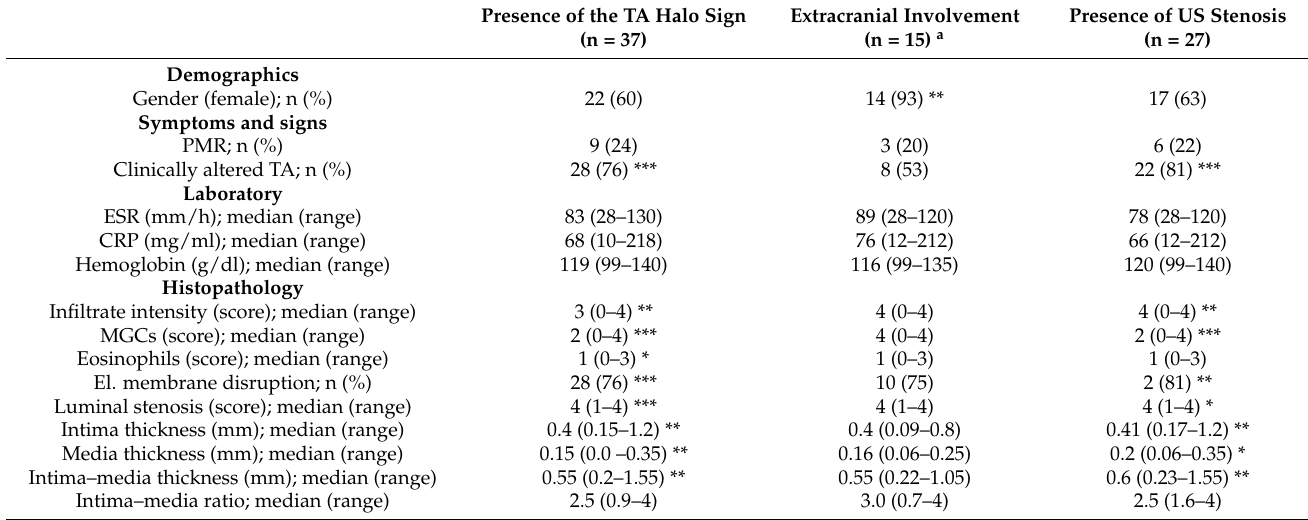
Table 3. TAB histopathology in relation to US examination parameters in GCA